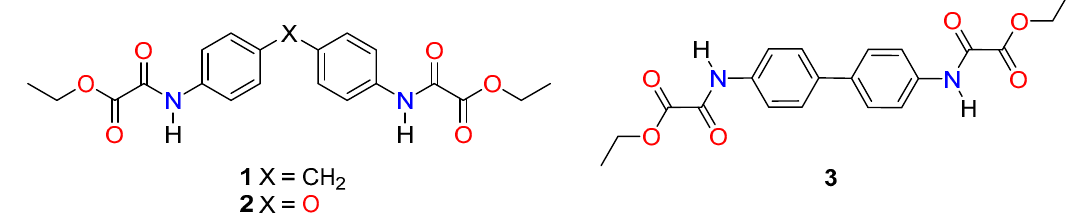
Figure 1. Diphenylene bis-diethyl dioxalamates in this study.